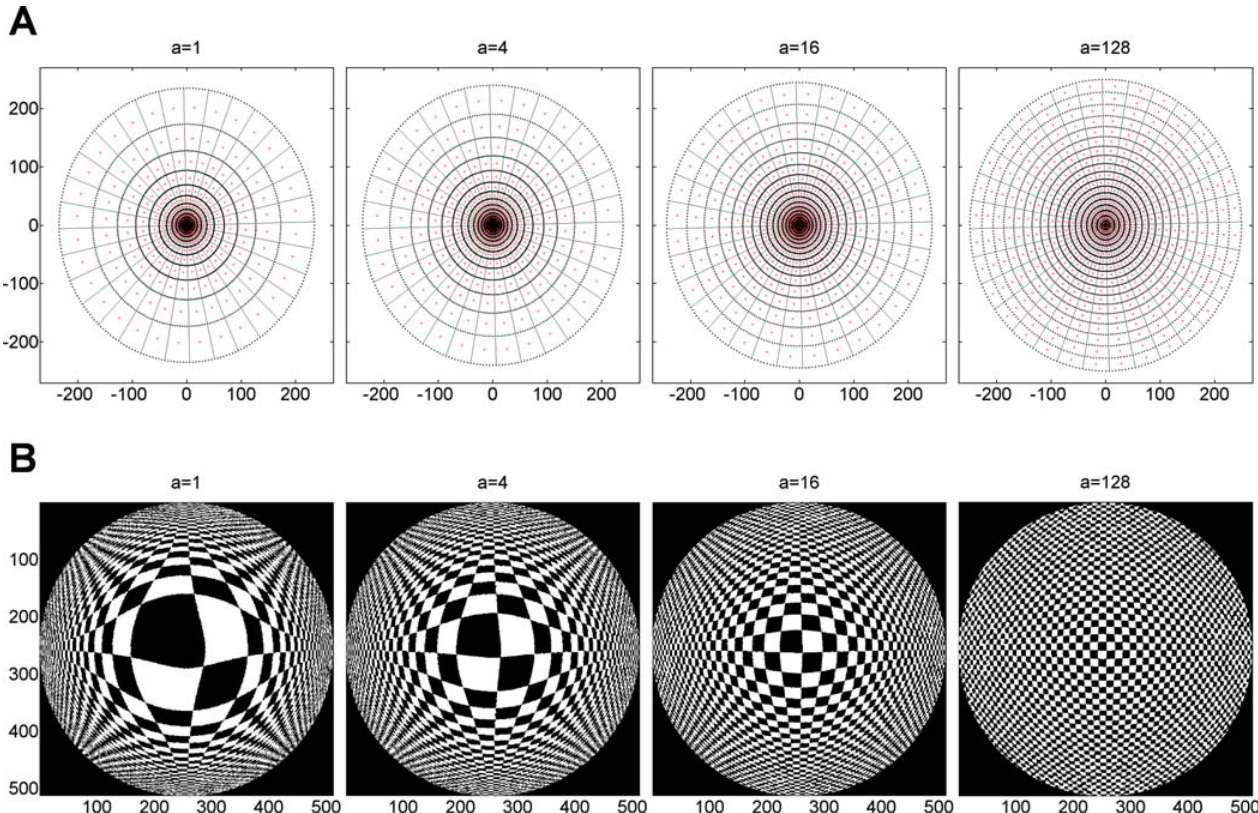
Figure 6. Illustration of the Retino-Cortical Mapping Process (A) Iso-density contours of photoreceptors (red crosses) for four selected values of the parameter a . The photoreceptors are arranged as 18 concentric rings. The mapping ‘‘ template ’’ is composed of nonoverlapping 32-ring sectors (receptive fields) formed by the intersection of rays originating at the center of the retina. The value of the photoreceptor is the average of the intensities of the photoreceptors (pixels) within the receptive field’s boundary. (B) Inverse mapping of ‘‘ cortical ’’ images back to the retinal (input) domain. The cortical magnification effect is due to inhomogeneous distribution of photoreceptors. A ‘‘ Cartesian ’’ visual image (here, a checkerboard; 512 3 512 pixels) is mapped onto a ‘‘ cortical ’’ plane. Mapping is dependent on the linear parameter a . The foveal part of visual field is magnified, that is, a larger piece of cortical area is devoted to processing. DOI: